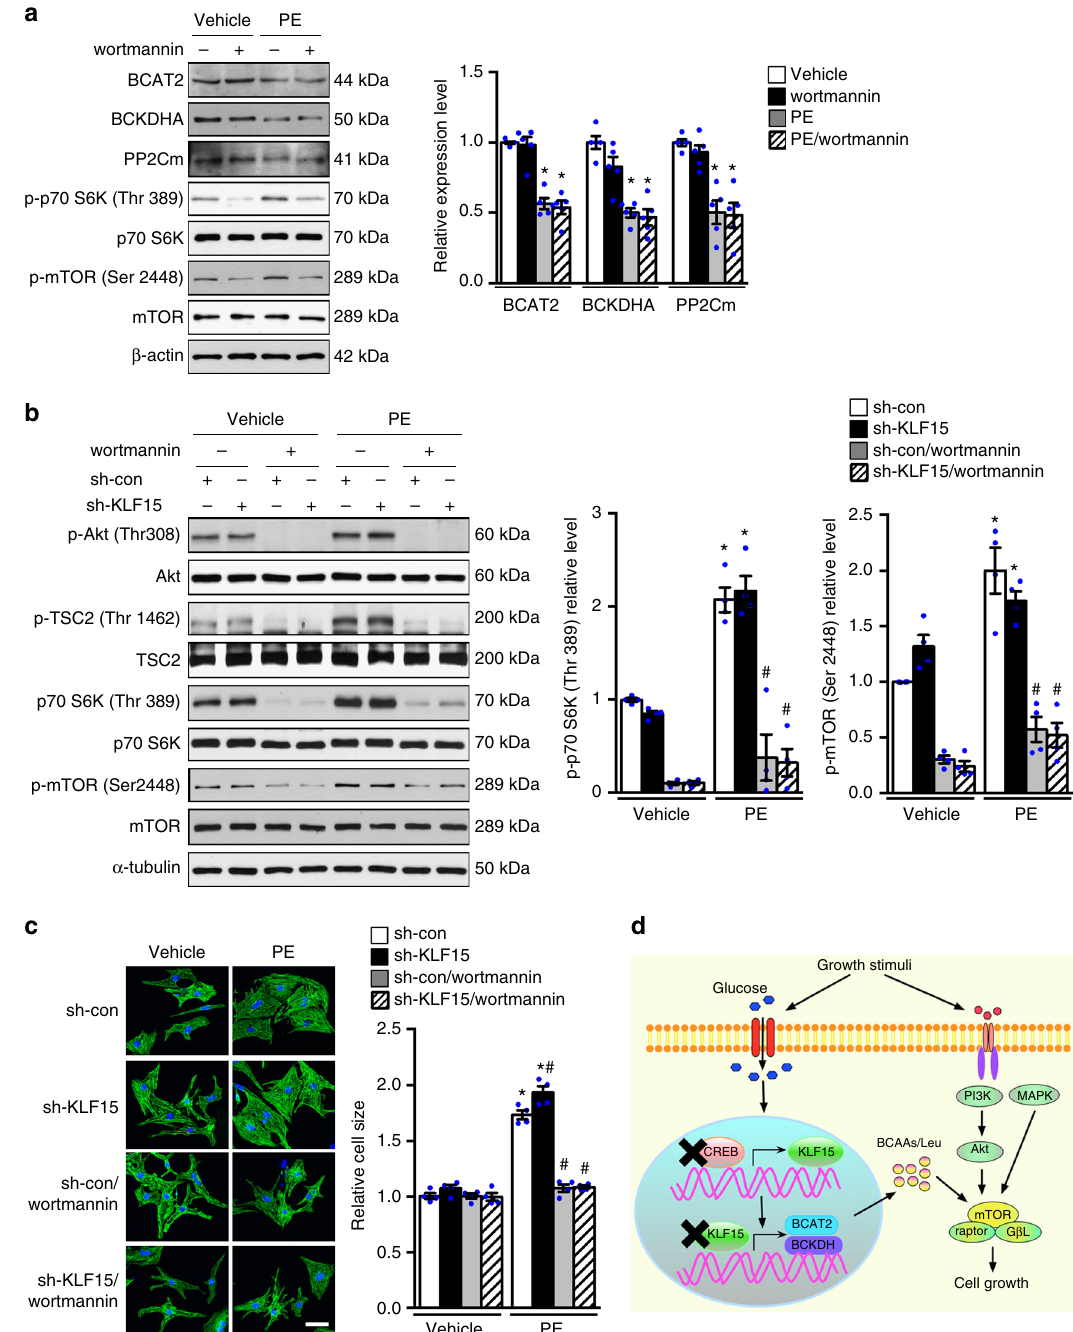
Fig. 8 Activation of mTOR requires both growth stimulus and metabolic checkpoint. a NRCMs with preincubation of wortmannin (2 μ M, 1 h) or vehicle were treated with phenylephrine (PE, 100 μ M) or vehicle for 6 h. Immunoblots of total cell lysates (left) and statistical analyses of densitomeric measurements of BCAT2, BCKDHA, and PP2Cm (right) are shown (* p < 0.05 vs. Vehicle, n = 5). b , c NRCMs transduced with indicated adenovirus were preincubated with 2 μ M wortmannin for 1 h and subsequently treated with phenylephrine (PE, 100 μ M) or vehicle. b Immunoblots of total cell lysates (left) and statistical analyses of densitomeric measurements of p-p70 S6K (Thr 389) and p-mTOR (Ser 2448) (right) are shown (* p < 0.05 vs. sh-con/Vehicle, # p < 0.05 vs. sh-con/PE, n = 4). c 48 h after PE treatment, myocytes were fi xed and stained with anti-Troponin T. Cell surface area in each group was quanti fi ed and expressed relative to the control (* p < 0.05 vs. sh-con/Vehicle, # p < 0.05 vs. sh-con/PE, n = 4). Scale bar, 25 μ m. d Schematic illustration of the working hypothesis on how glucose regulates cell growth through modulating KLF15 mediated transcriptional control of BCAA degradation. Data shown as mean ± s.e.m. P values were determined using one-way ANOVA followed by Newman-Keuls comparison test ( a , b ) or Kruskal – Wallis test followed by Dunn ’ s comparison test ( c